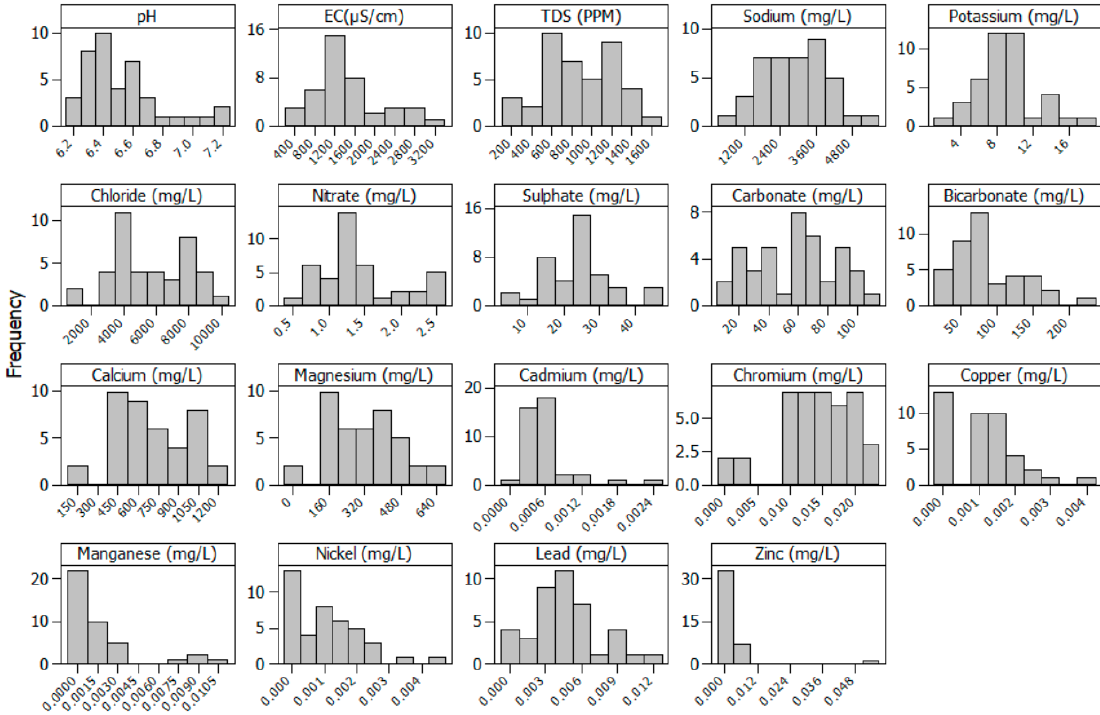
Figure 4. Histogram of water parameters. Table 3. Diagonal table of dissimilarities that resulted from the Dunn test.